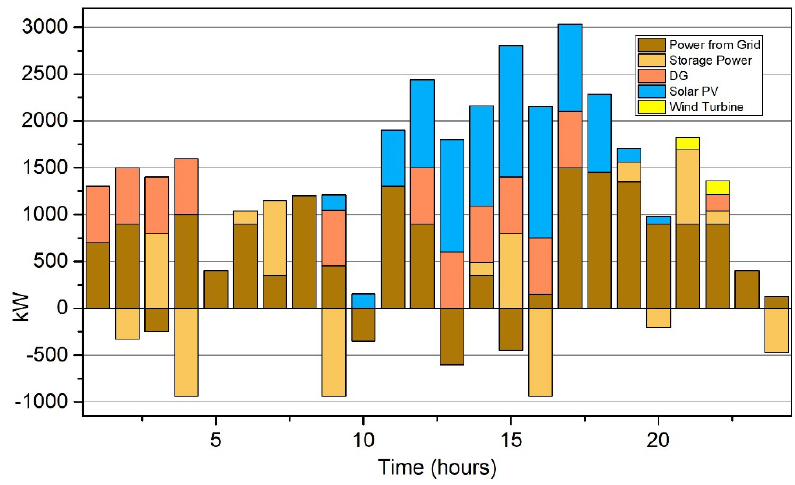
Figure 11. Grid scheduling for the proposed case (5). Table 6. Profile of the case studies on the grid electricity cost.